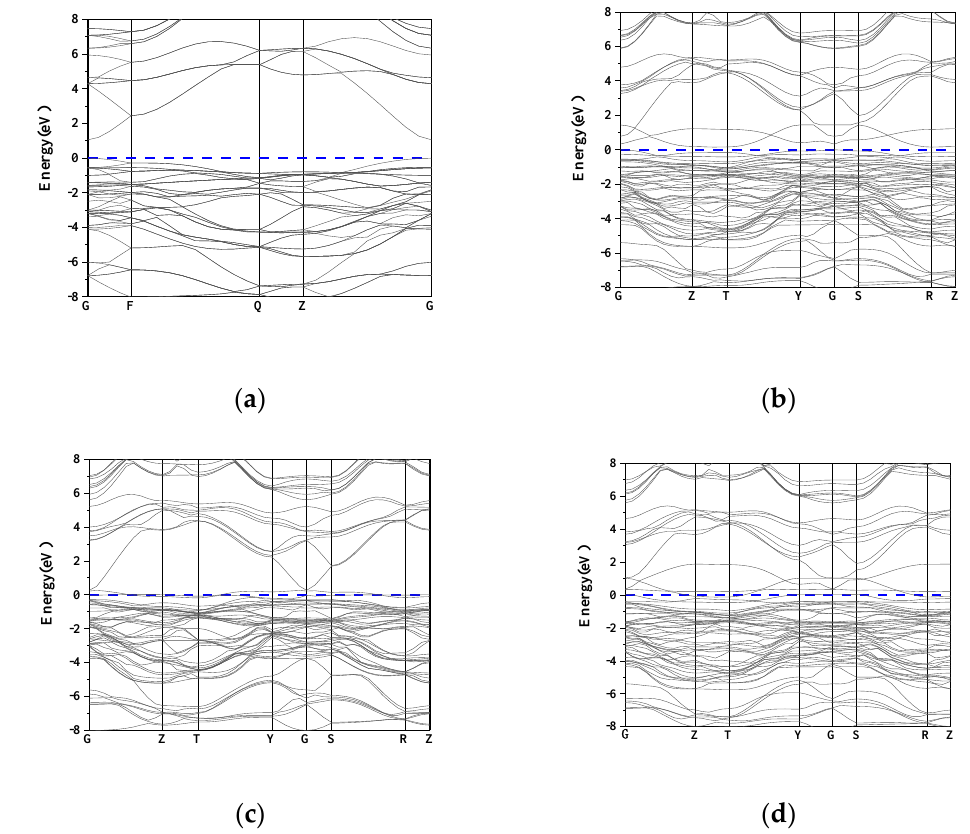
Figure 2. Band structure: ( a ). SnO 2 ; ( b ). SnO 2 – Ni; ( c ). SnO 2 – N; ( d ). SnO 2 – Ni –